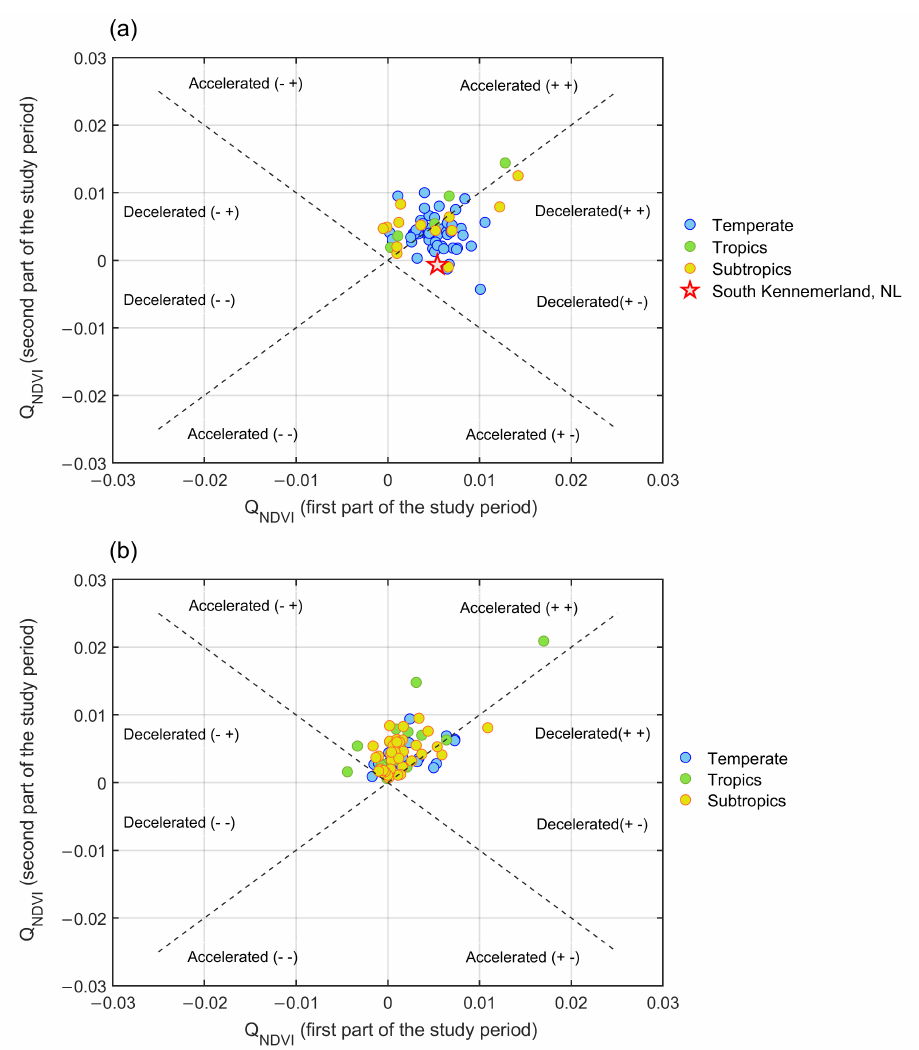
Figure 9. Sen’s slope Q NDVI during the second versus the first part of the study period for sites with ( a ) NDVI > 0.3 and ( b ) NDVI ≤ 0.3. In each panel, the data are split into the three climatic zones